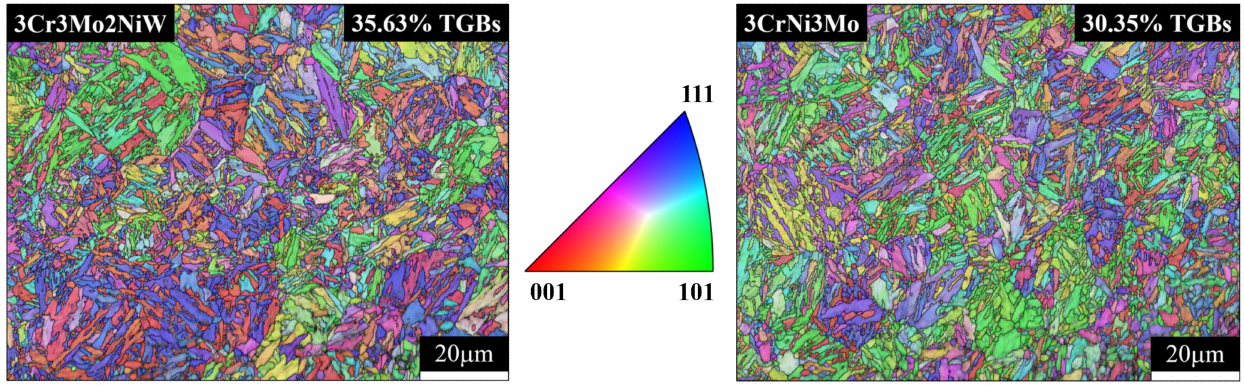
Figure 1. IPFs of two Cr-Ni-Mo hot-work die steels after heat